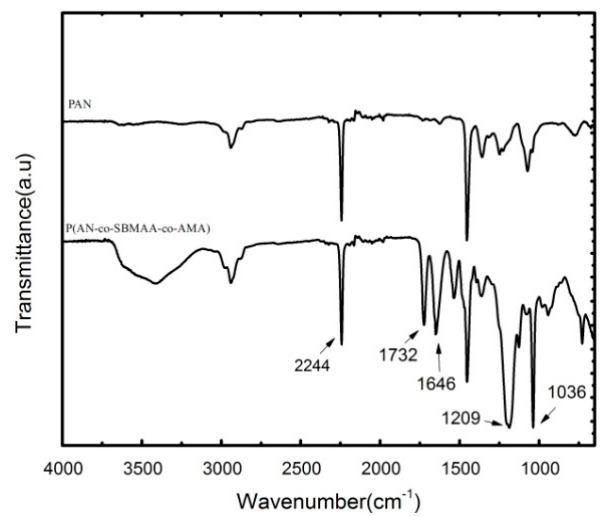
Figure 2. FT-IR spectra of P(AN-co-SBMAA-co-AMA) copolymers.